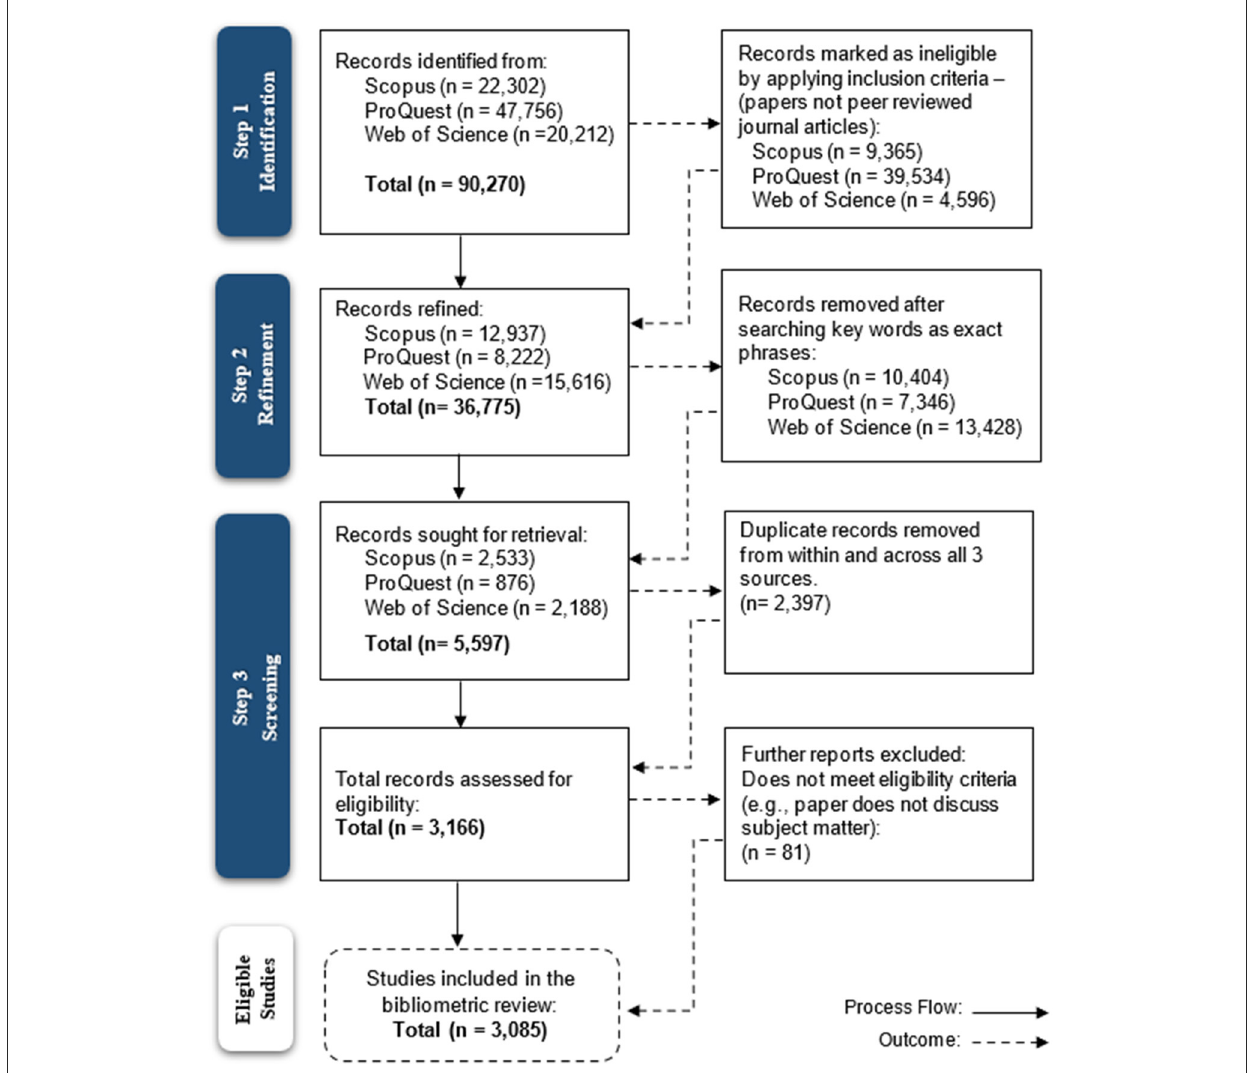
FIGURE1 PRISMA flow diagram for bibliometric literature review process (Adapted from Page et al., 2021).